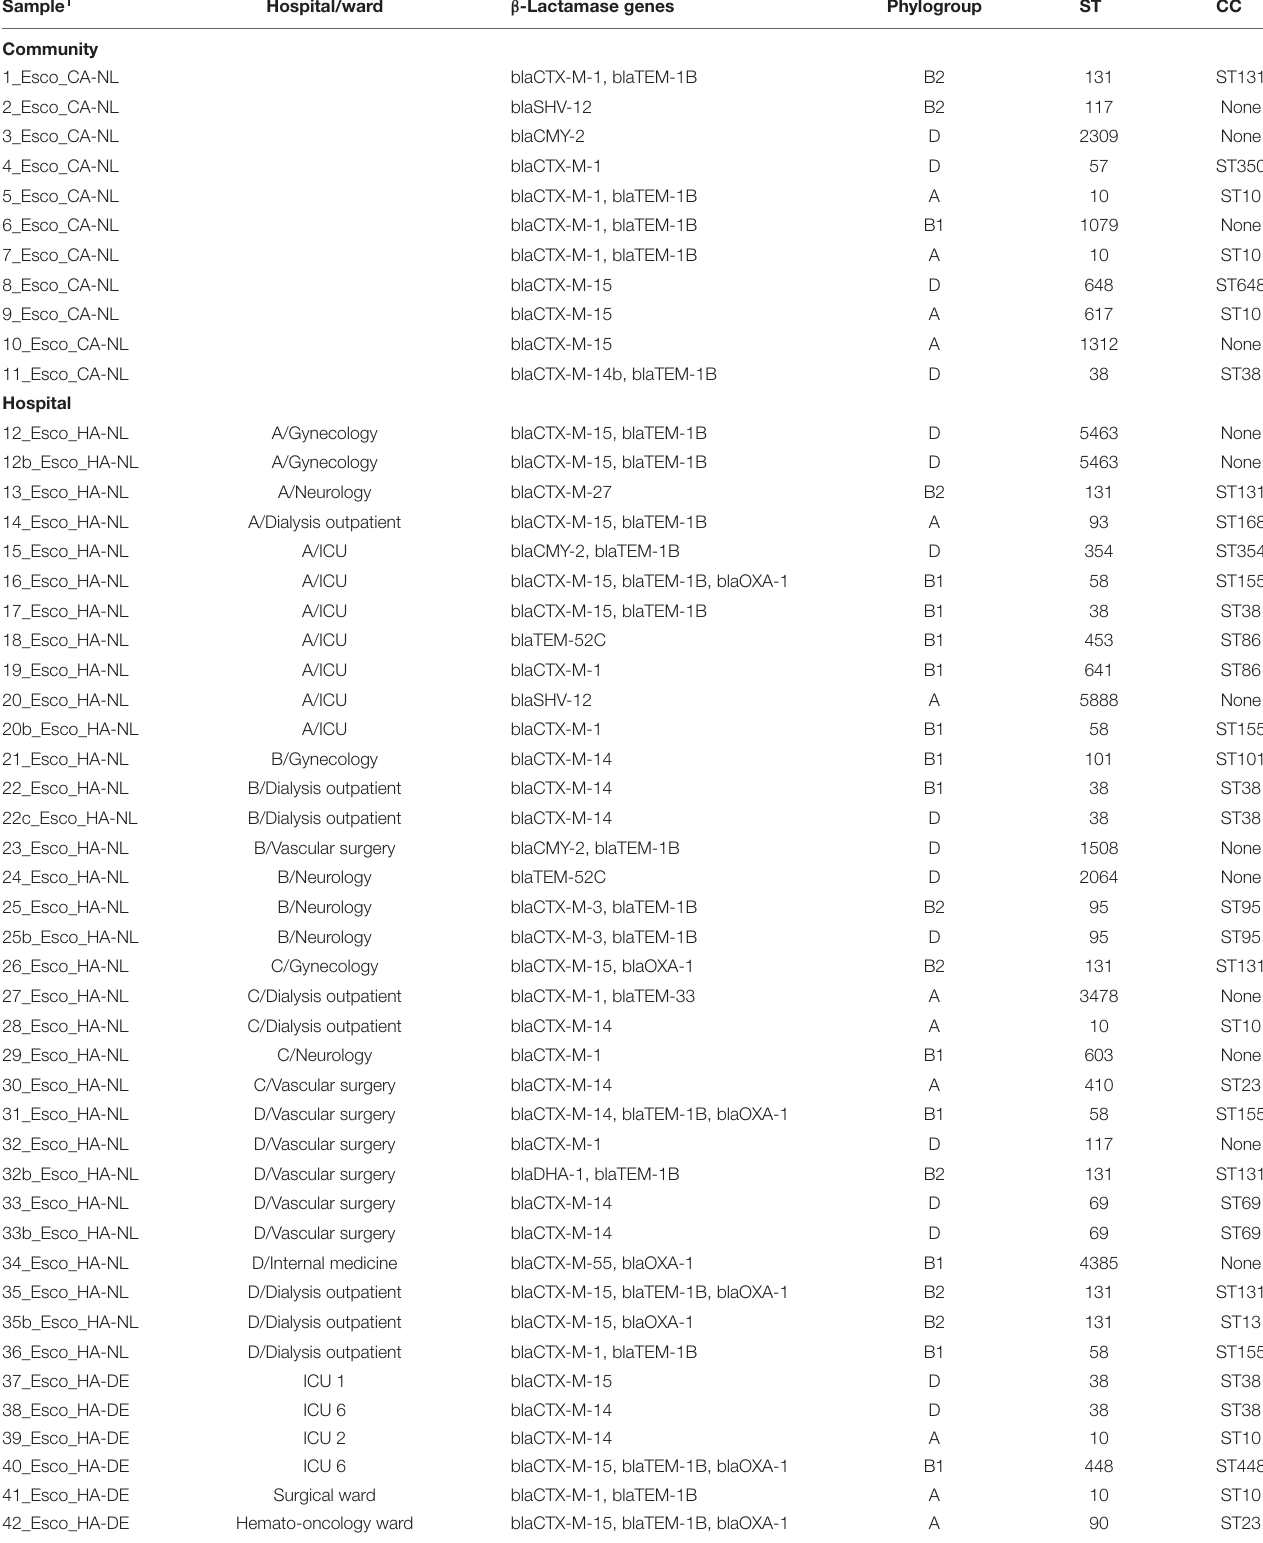
TABLE 2 | Molecular characterization of the E. coli isolates from the community and hospital patients in the Netherlands and Germany. Sample